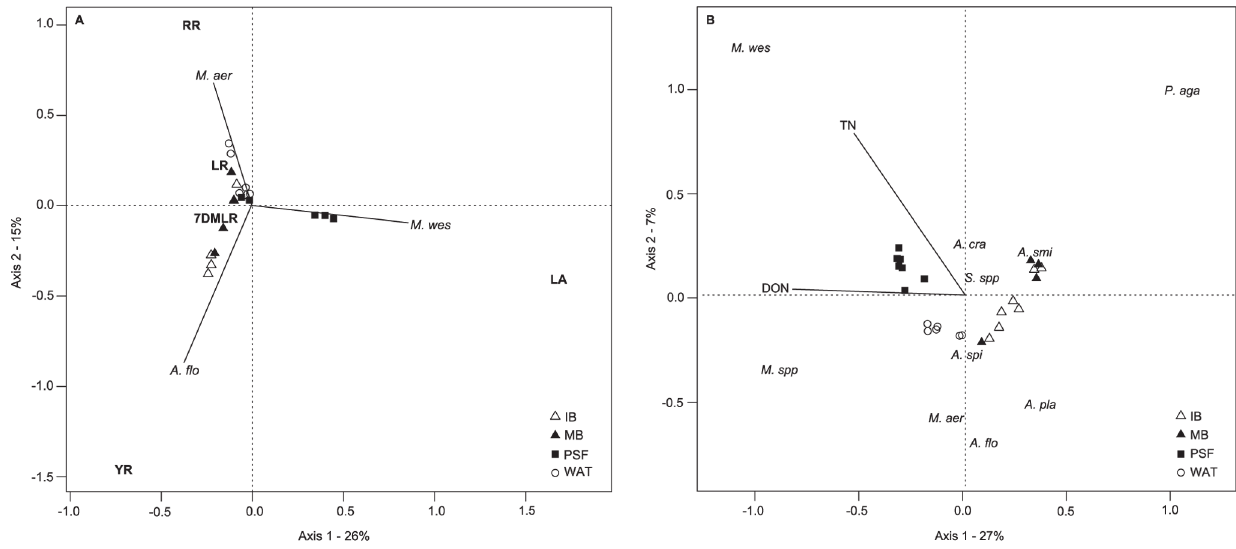
Figure 5. Redundancy analysis (RDA) of environmental variables, cyanobacteria species and MC congeners. RDA performed with forward selection by permutation (n-perm=999) on A) Species biomass as explanatory variables for MC congener composition ( R 2 adj. =0.40, p =0.001) where combined Microcystis aeruginosa, Microcystis wesenbergii and Aphanizomenon flos-aquae explain 40% of the variation in MC congener concentration; and B) Environmental factors as explanatory variables for cyanobacterial species biomass ( R 2 adj. =0.28, p =0.001) where combined TN and DON explain 28% of the variation in species composition (for species abbreviations, see legend in Figure 4).